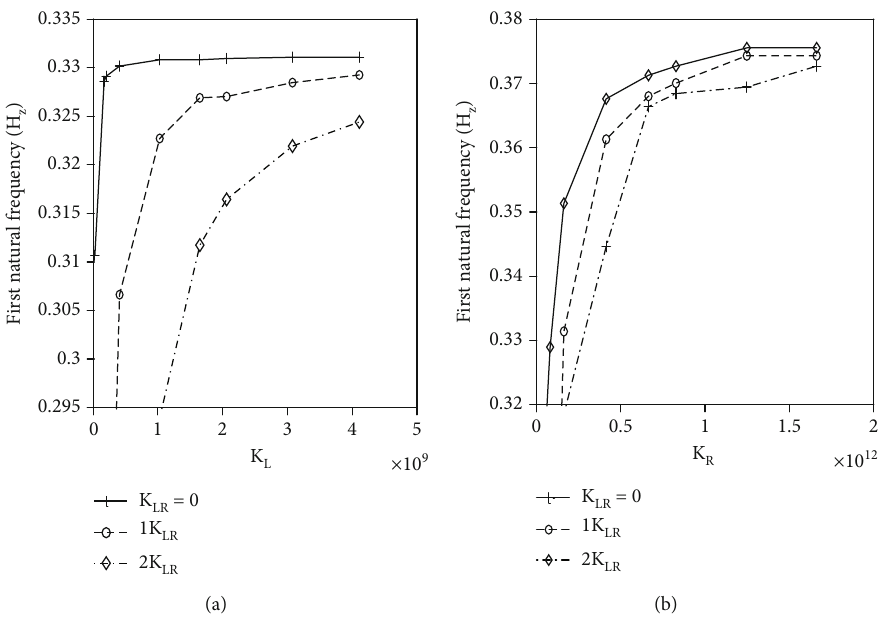
Figure 5: Natural frequency as a function of (a) lateral sti ff ness and (b) rotational sti ff